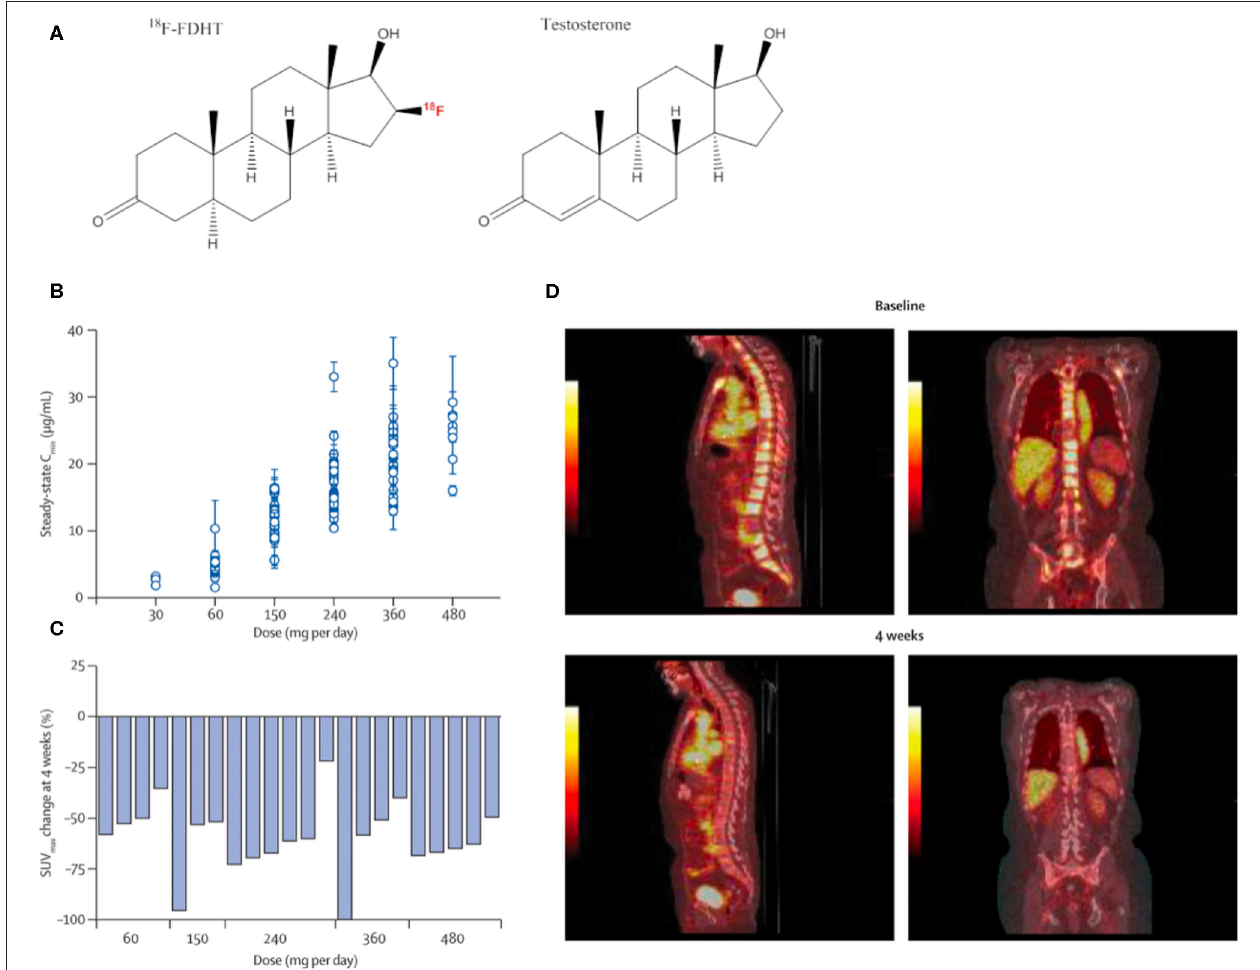
FIGURE 2 | Quantitative imaging of the androgen receptor. [ 18 F]-FDHT, which annotates the AR, the central molecular driver of prostate cancer development and progression, is an effective imaging tool to evaluate pharmacodynamic features of candidate therapies. MDV3100 treatment, a second-generation orally bioavailable anti-androgen, was tested in men with castrate-resistant prostate cancer. (A) Chemical structure of positron-emitting 18 F-FDHT and testosterone. (B) MDV3100 serum concentration by dose level. (C) Representative baseline and treatment scans showing marked decrease in radio-androgen uptake in skeletal metastases. Reproduced from Scher et al. ( 16) (D) Change in standardized uptake value of [ 18 F]-FDHT PET for men at baseline compared to 4 weeks of